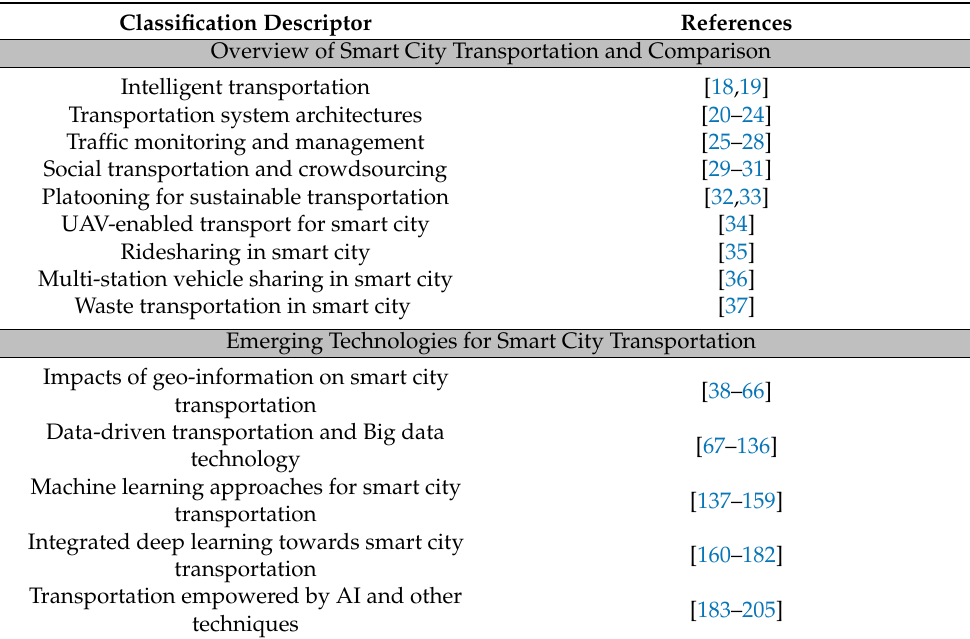
Table 1. Classification descriptors and